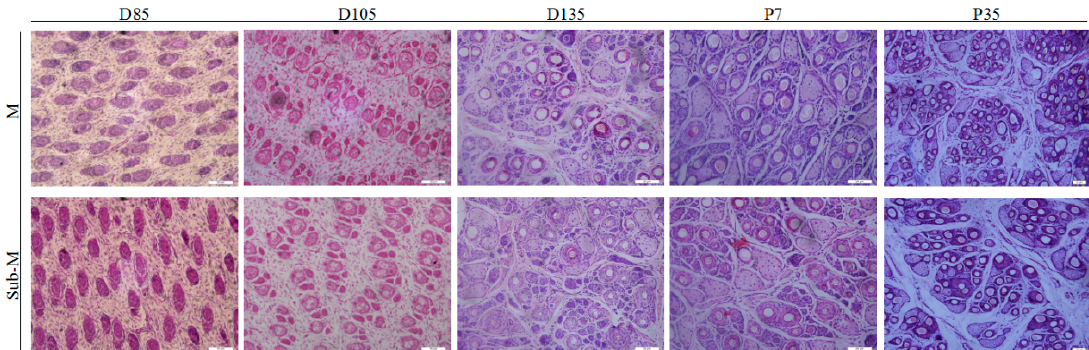
Figure 2. Morphogenesis and development of wool follicles in pregnancy maintenance and nutritional restriction group of Merino ewes. Lateral skin from fetal and lamb bodies was obtained; the deparaffinized sections were stained with H&E. Scale bars: 20 µm. The timeline at the top of the diagram represents the gestational period: D85, 85 days of gestation; D105, 105 days of gestation; D135, 135 days of gestation; P7, 7 days after birth; and P35, 35 days after birth.